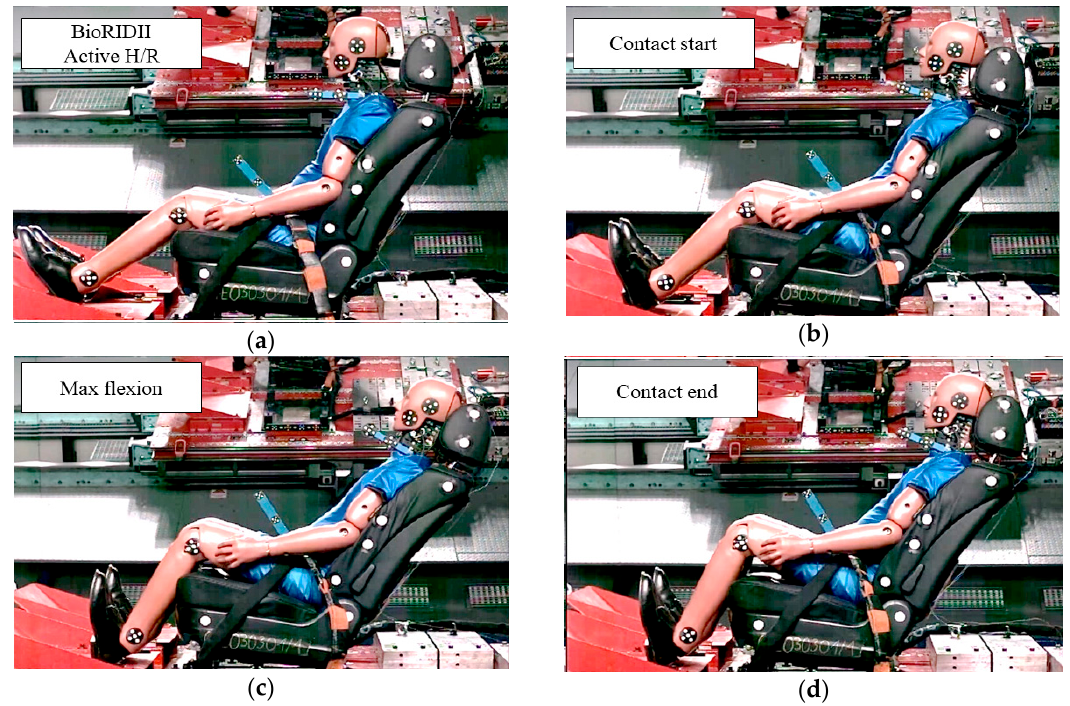
Figure 5. Image of sled test with active headrest: ( a ) initial setting (0 ms); ( b ) contact start (80 ms); ( c )